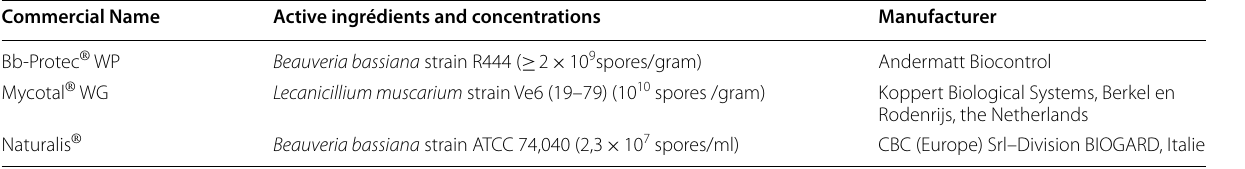
Table 1 Commercial entomopathogenic fungi used in the